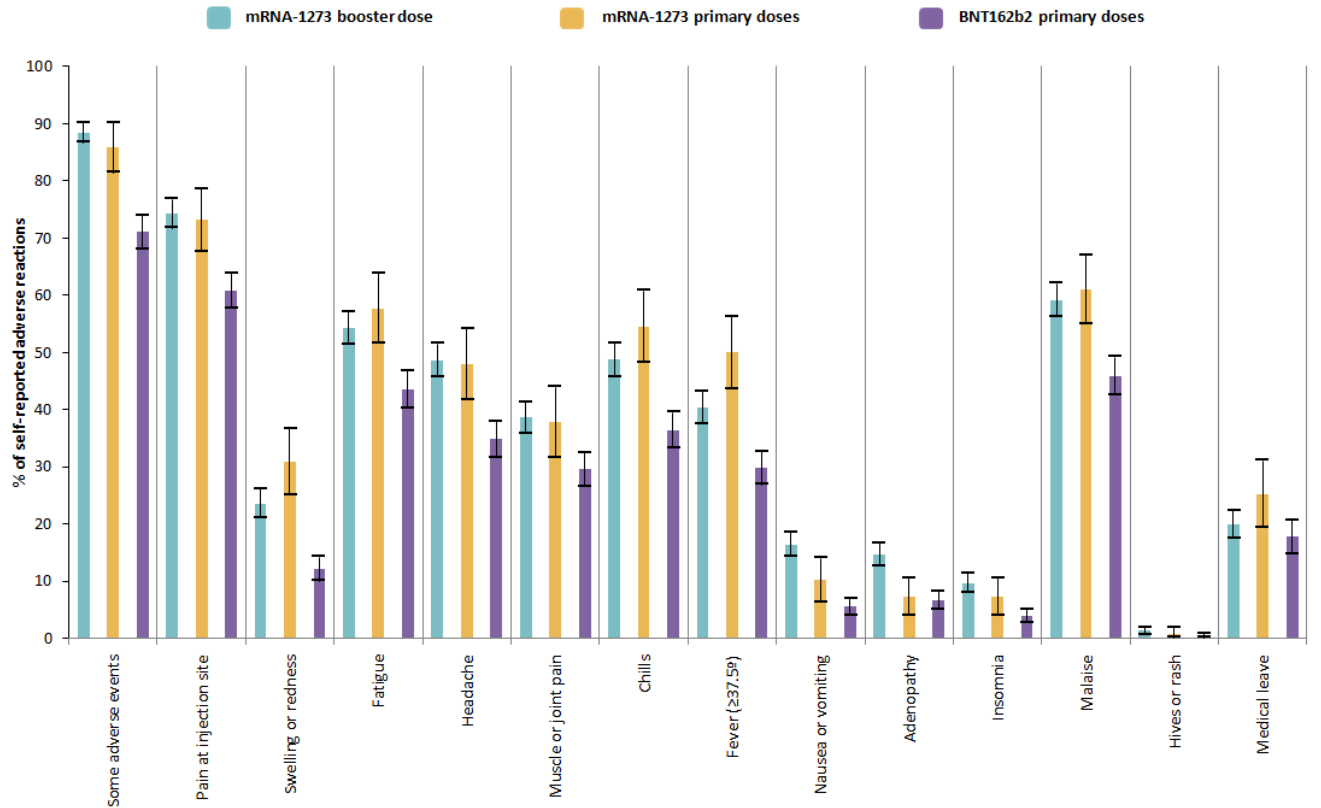
Figure 1. The self-reported adverse reactions to the COVID-19 vaccination when comparing the primary doses versus the booster. Table 3. The self-reported adverse reaction to the COVID-19 booster when comparing the homologous booster versus the heterologous